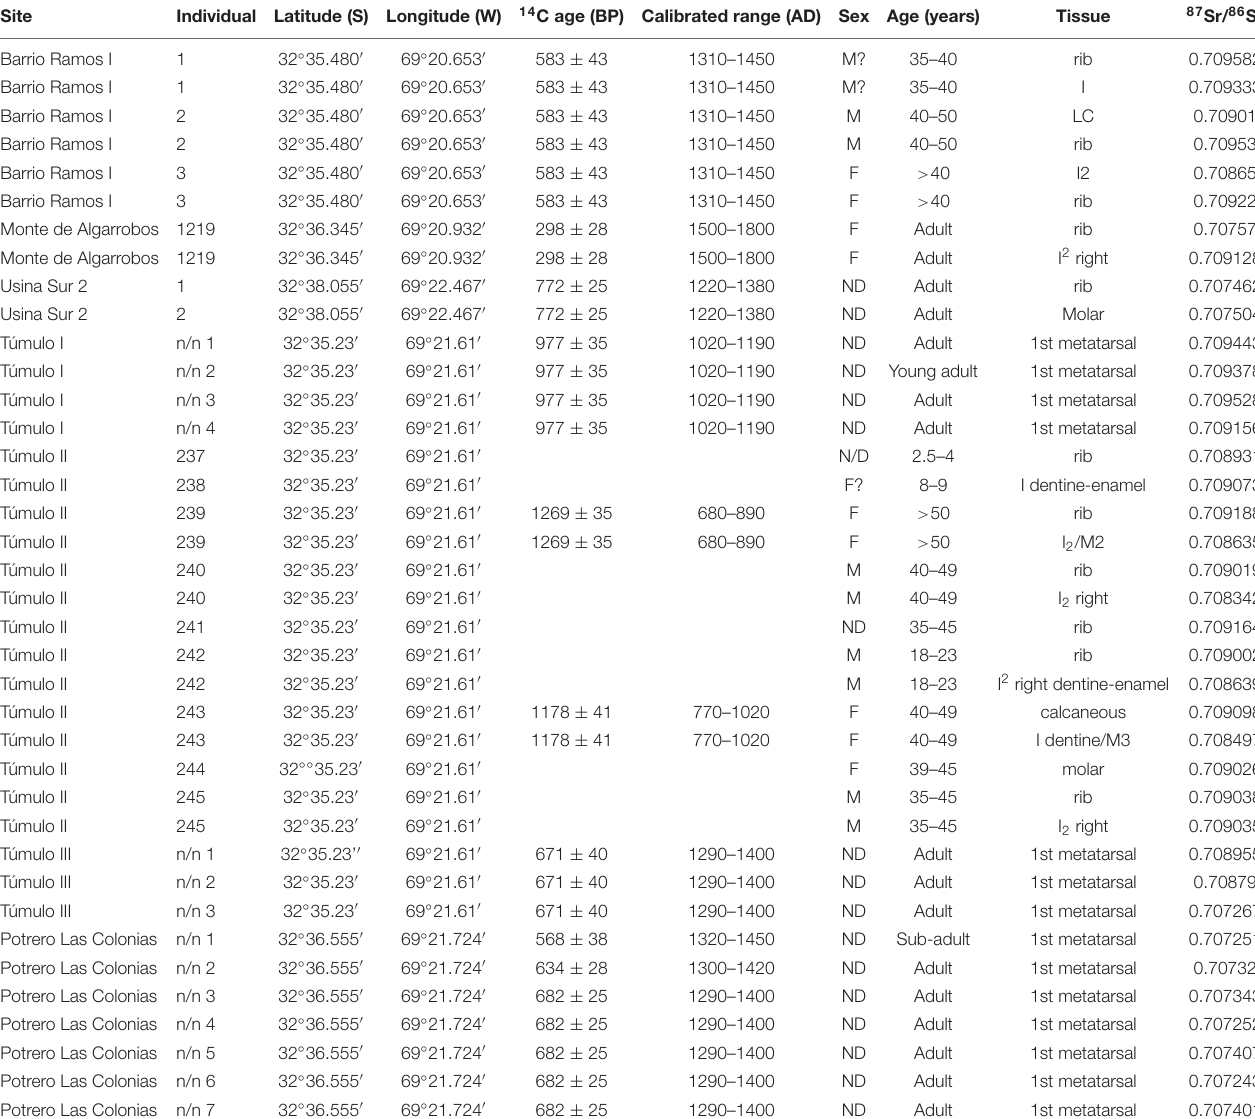
TABLE 4 | 87 Sr/ 86 Sr results and contextual information for human remains from the Uspallata Valley, northwestern Mendoza, Argentina (from Barberena et al., 2020).